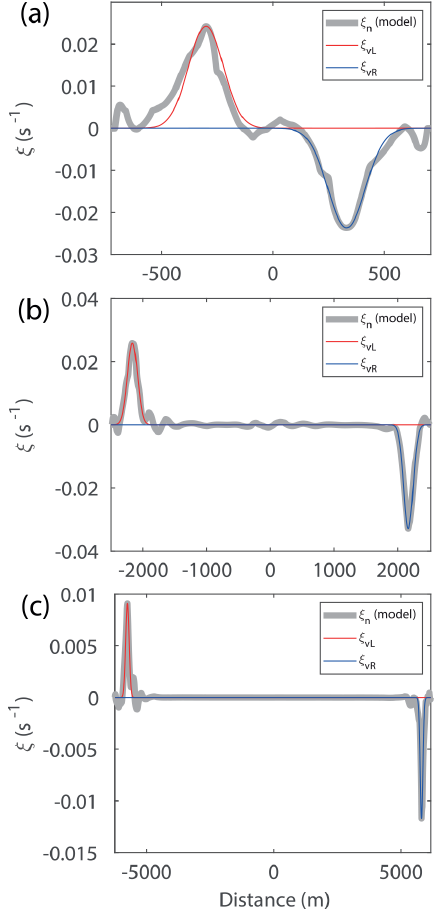
Figure 11. The vorticity distribution along a line intersecting the two vortices at each side of the strait at separation time. Panels (a– c) are from the three simulations shown in Figs. 5 to 7, respectively. The gray line shows the vorticity distribution from the model out- put, while the red and blue lines are calculated vorticity distribution using Eq. (11b) for the left and right vortex, respectively.